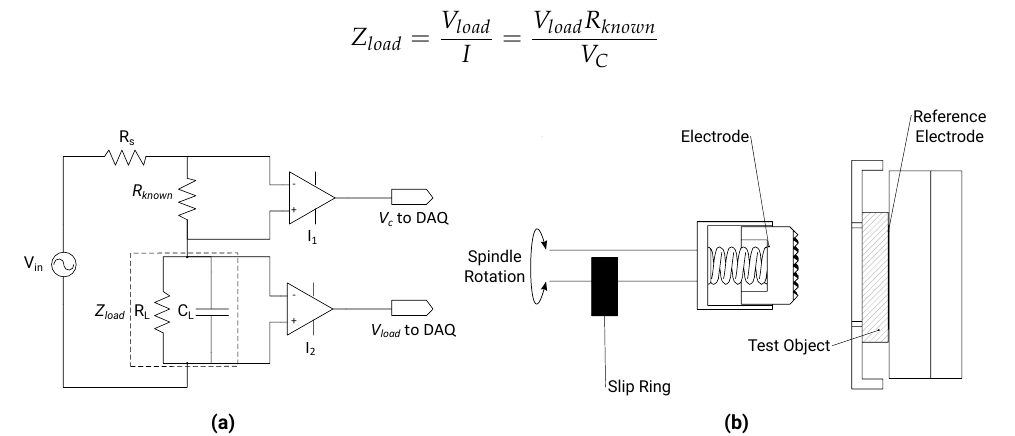
Figure 4. Impedance measurement ( a ) circuit diagram ( b ) electrical connections to reference and actuated electrode via slip